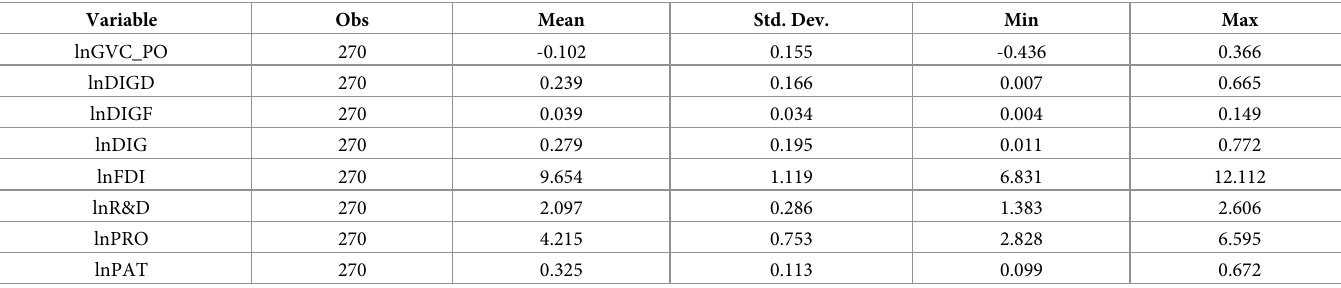
Table 2. Descriptive statistics of